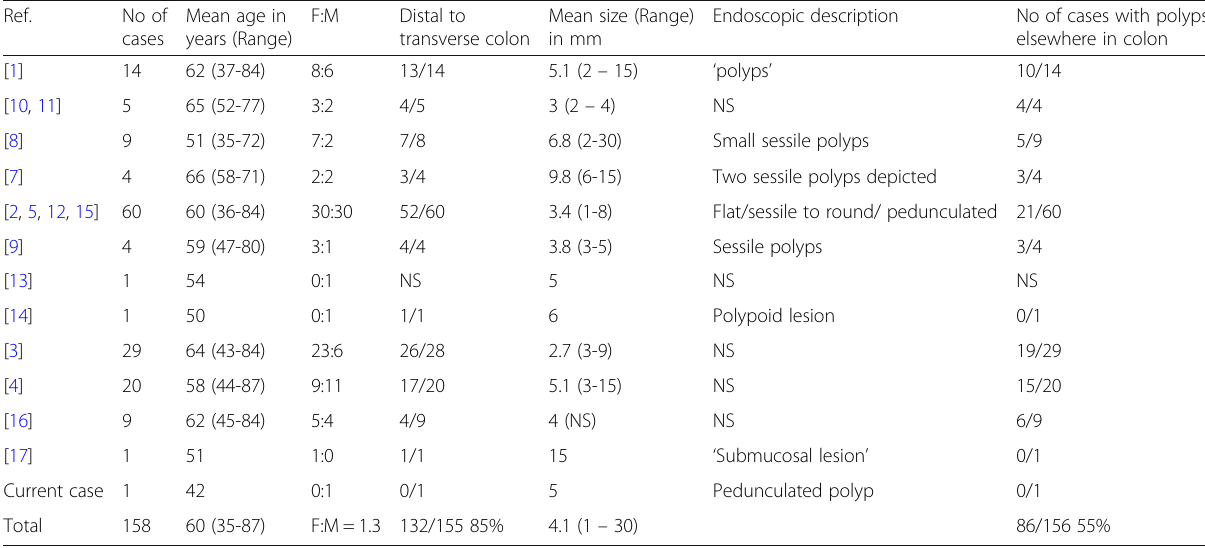
Table 1 Clinical features of previously reported colorectal perineuriomas including the current case (Total: 158)